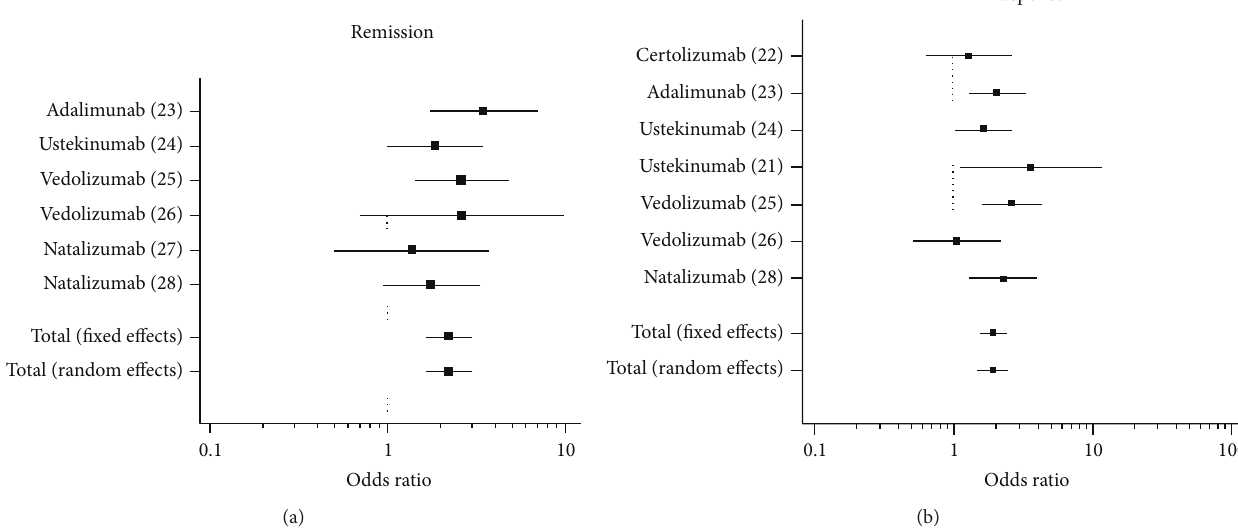
Figure 2: Traditional meta-analysis of published studies for induction of remission (a) and response (b) in anti-TNF-experienced CD patients. The name of the drug and the reference of the study is reported. Global comparison showed signi fi cant e ffi cacy of treatment comparing with placebo.